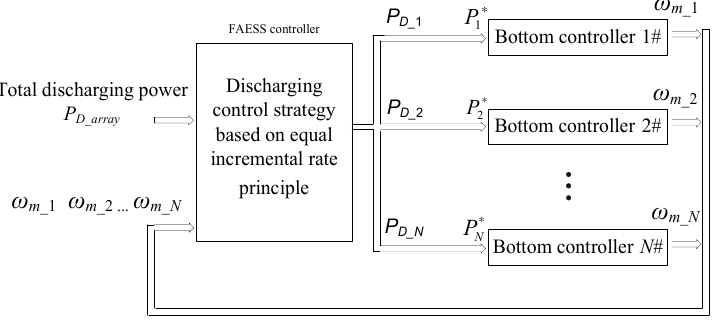
Figure 13. Implementation of coordination control of discharging.